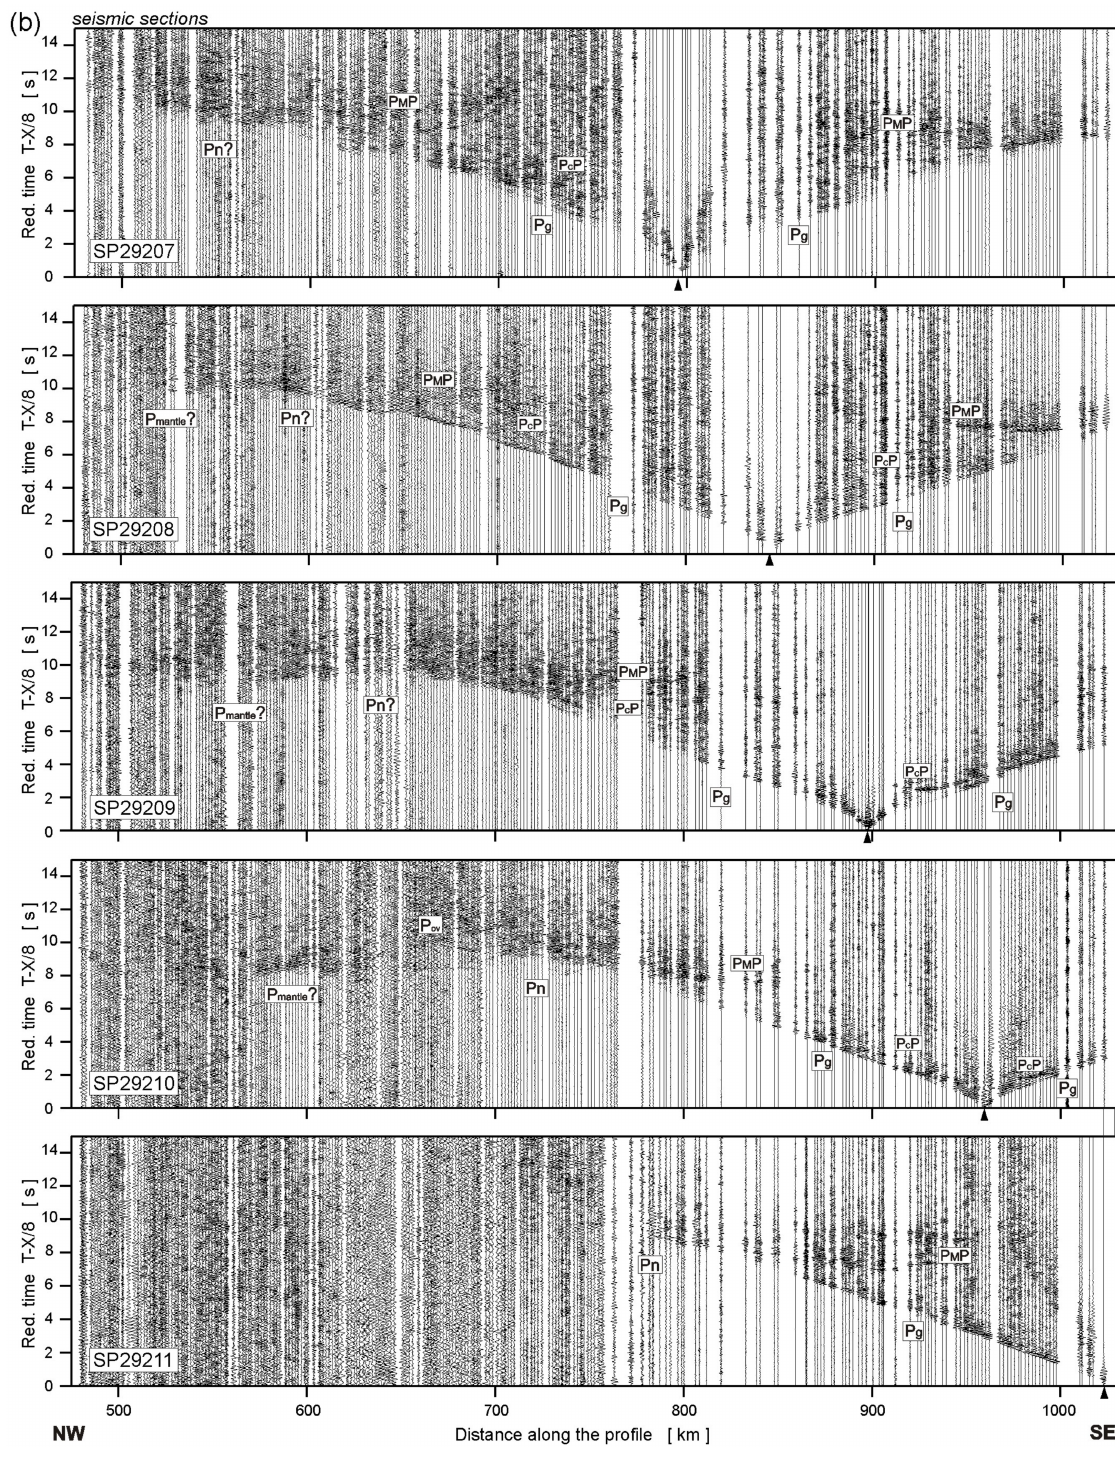
Figure 5. Examples of trace-normalized, vertical-component seismic record sections for ( a ) SP29201- SP29206 and ( b ) SP29207-SP29211. A band-pass filter (2–15 Hz) has been applied. P sed —P refractions from sedimentary layers; P g —P refractions from the upper and middle crystalline crust; P ov— P overcritical crustal phases; P c P—P reflections from the mid-crustal discontinuities; P M P—P reflections from the Moho boundary; P n —P refractions from the sub-Moho upper mantle; P mantle —lower lithospheric P phases; LVZ—low-velocity zone. The reduction velocity is 8.0